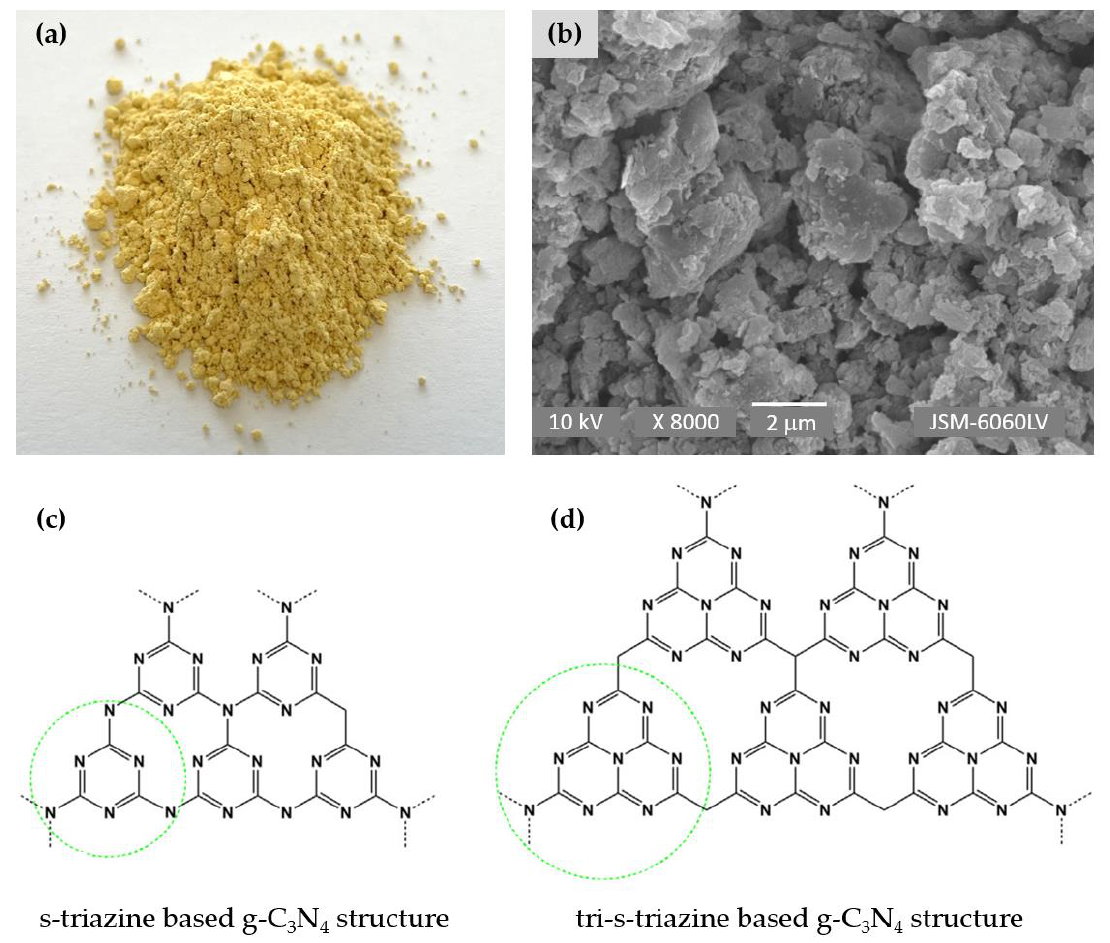
Figure 1. Schematic presentation of g-C 3 N 4 : photo of g-C 3 N 4 powder ( a ), SEM image of g-C 3 N 4 nanosheets ( b ), s-triazine ( c ), and tri-s-triazine ( d ) structure of g-C 3 N 4 . Reprinted with permission from [19]. Copyright 2020, Elsevier.